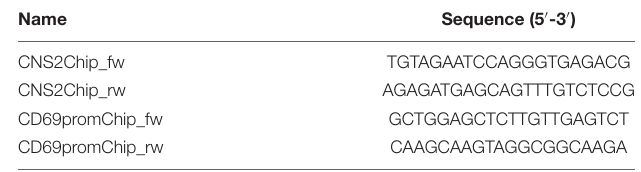
TABLE 5 | Primers sequences used for Chip analysis.